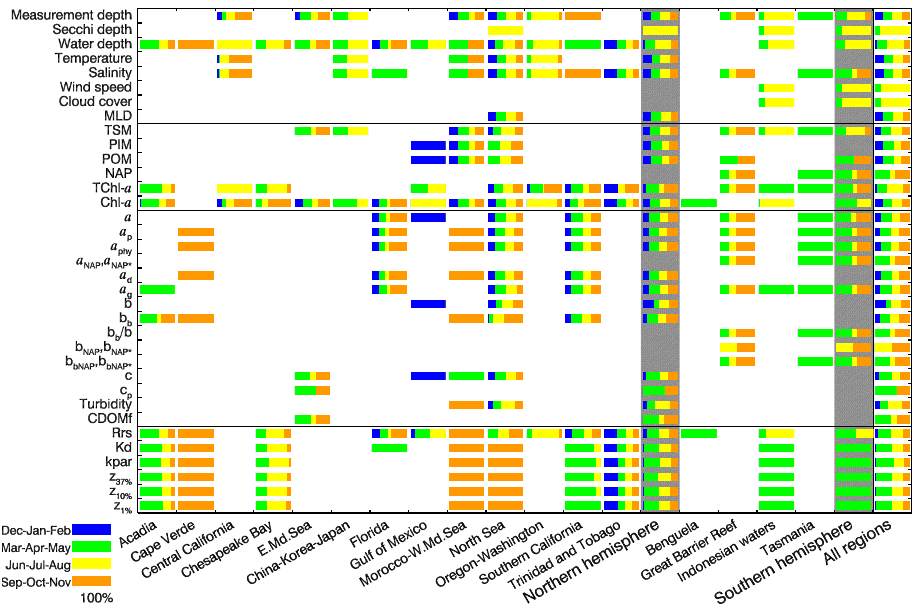
Figure 3. Seasonal availability of the metadata, biogeochemical, IOP, and AOP measurements from the CoastColour sites within the CCRR match-up data